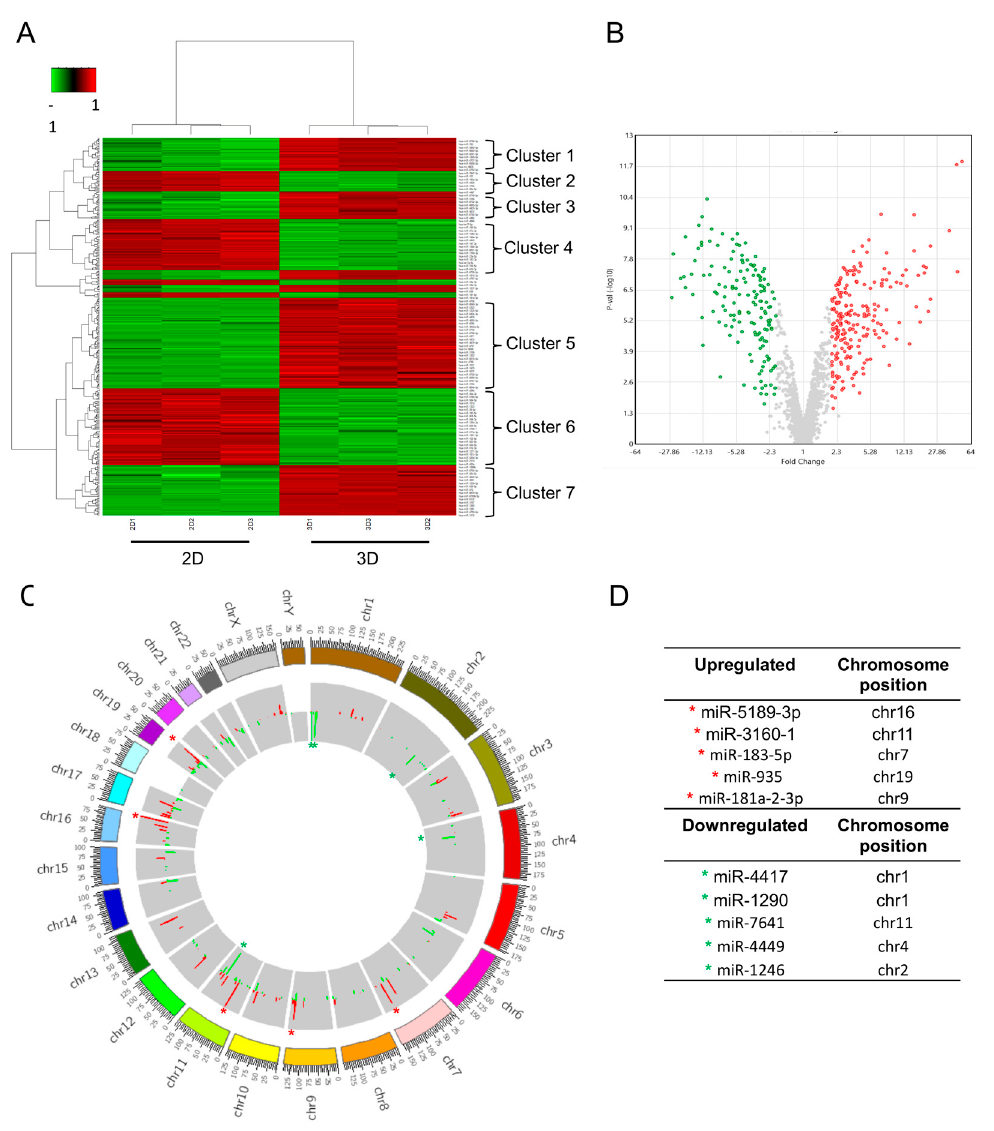
Figure 3. Microarray analysis of differentially expressed miRNAs in 2D versus 3D cultures of Hs578T breast cancer cells. ( A ) Heat map showing the signal intensity corresponding to differential expression of miRNAs in 2D and 3D cultures. Each column represents an individual sample, and each row represents a different miRNA. Unsupervised hierarchical clustering of differentially expressed miRNAs was performed using Pearson’s correlation coefficient. The expression levels of each miRNA in a single sample are represented according to the color scale. Red represents high expression levels, whereas green represents low expression levels. ( B ) Volcano plot graph represents the expression of miRNAs between 3D and 2D cultures. The y -axis represents the log2 ratio of the fold change and the x -axis represents − log10 ( p -value). The red color indicates that the expression of miRNAs increased significantly more than 2-fold, whereas the green color indicates that the expression of miRNAs decreased significantly more than 2-fold in 3D organotypic cultures, compared to the 2D control group. ( C ) Circus plot. The circle graph represents the distribution of differentially expressed miRNAs in the chromosomes. The outer-layer circle denotes the chromosome map of the human genome. The inner layers represent the distribution of differentially expressed miRNAs on different chromosomes, respectively. The red and green colors represent overexpression and repression, respectively. ( D ) The five most overexpressed and downregulated miRNAs in 3D cultures, indicated in the circle graph with a red and green asterisk, respectively.